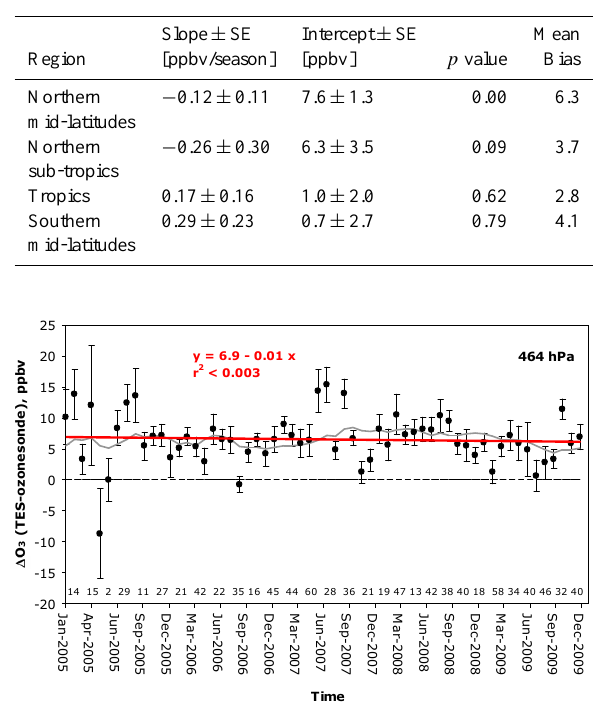
Figure 6. Time series of the monthly mean bias between TES and sonde free troposheric2 Fig. 6. Time series of the monthly mean bias between TES and ozone for the northern mid-latitudes at 464 hPa in the period 2005-2009. Black symbols3 sonde free tropospheric O 3 for the northern mid-latitudes at 464hPa indicate the monthly mean bias (TES-ozonesonde) and their standard error. The red line4 in the period 2005–2009. Black symbols indicate the monthly shows the result of a (unweighted) linear regression analysis to the monthly mean biases. The5 mean bias (TES–ozonesonde) and their standard error. The red inset (in red) shows the result of the linear regression to the bias (intercept: +6.9 ppbv, slope: -6 line shows the result of a (unweighted) linear regression analy- 0.01 ppbv/month). The grey line indicates the 12-month running mean of the TES-7 sis to the monthly mean biases. The inset (in red) shows the re- ozonesonde bias. The numbers close to the x-as represent the amount of data-pairs given for8 sult of the linear regression to the bias (intercept: + 6.9ppbv, slope: − 0.01ppbv/month). The grey line indicates the 12-month running each two months.9 mean of the TES–ozonesonde bias. The numbers close to the x-axis represent the amount of data pairs given for each two months.